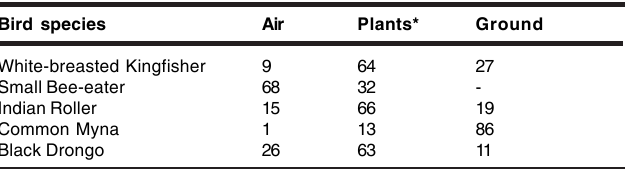
Table 3. Percentage use of various foraging substrates by insectivorous birds Bird species